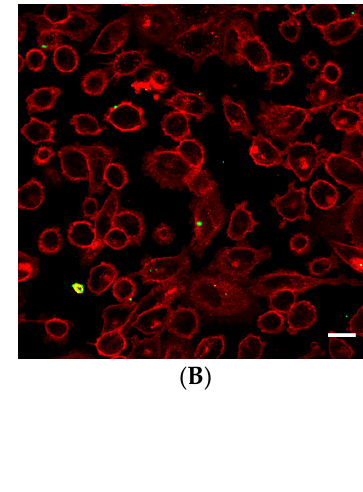
( D ) Figure 4. Representative overview confocal images of PC3 cells showing Cell Masks (red) and nanoparticles (green) both on the surface and inside the cells. In addition to the free nanoparticles, the cells were treated with ( A ) nanoparticle-loaded microbubbles but no ultrasound at 37 ° C (con- trol), ( B ) nanoparticle-loaded microbubbles and ultrasound at 4 ° C, ( C ) nanoparticle-loaded mi- crobubbles and ultrasound at 37 ° C or ( D ) Sonazoid and ultrasound at 37 ° C. The scale bars are 20 µm.